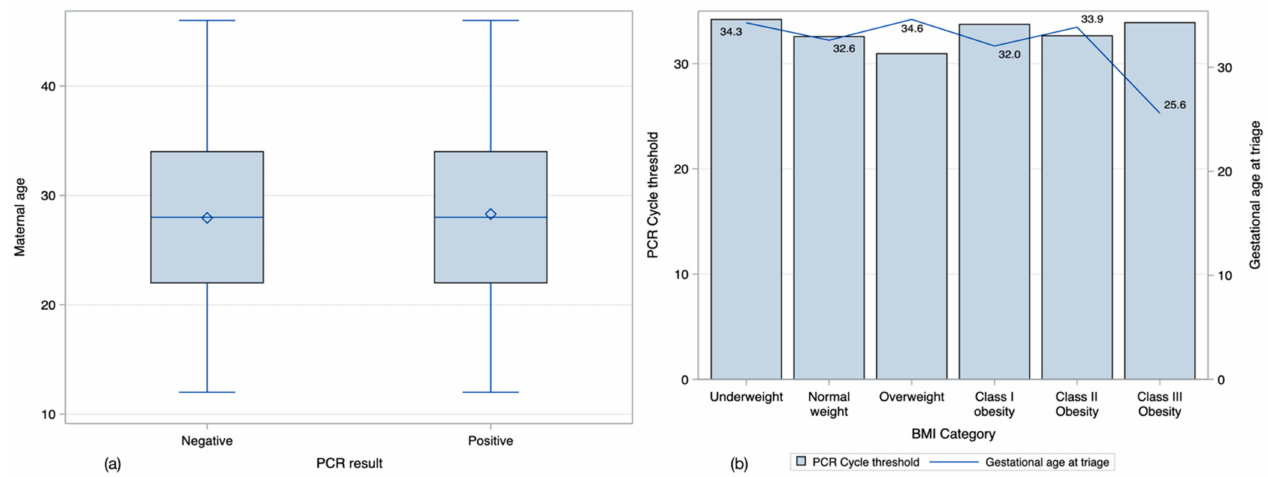
Figure 1. Age and BMI characteristics. Maternal age was similar between women who tested positive and negative to COVID ( a ). Women who were overweight tended to have lower C T values, and women with class three obesity had the lowest gestational age at triage ( b ).